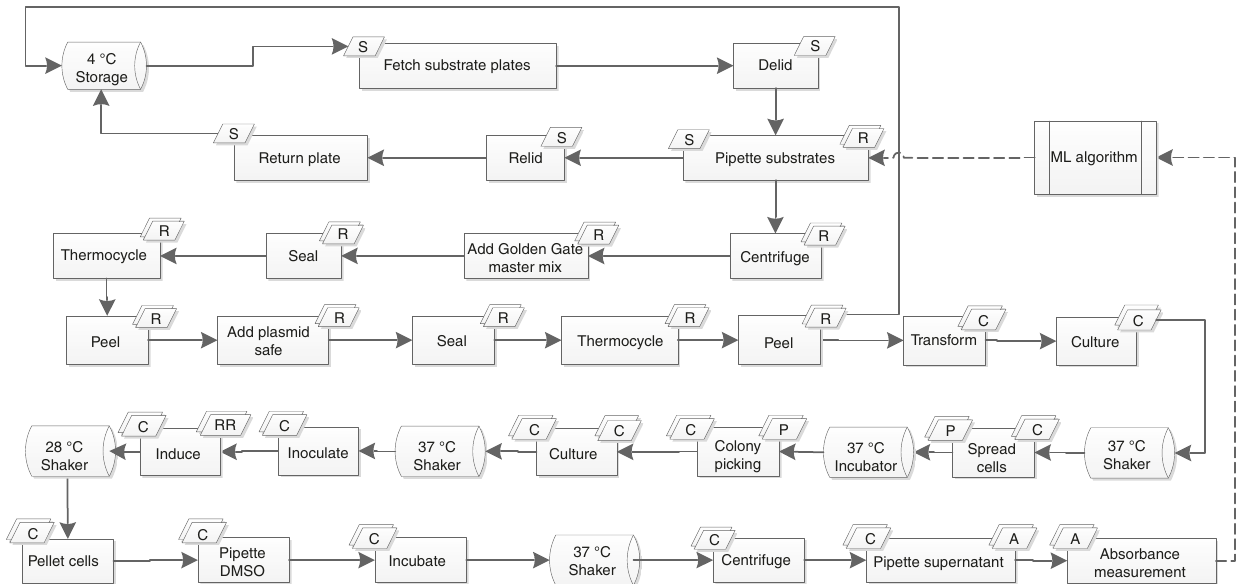
Fig. 5 The overall fully automated pathway optimization work fl ow. The machine learning algorithm picks the plasmids to be assembled and returns the list to iBioFAB to perform the assembly. The assembled products are then transformed, and four single colonies are isolated for lycopene quanti fi cation and OD measurement. The resulting data are then given to the machine learning algorithm to pick the next set of points to be